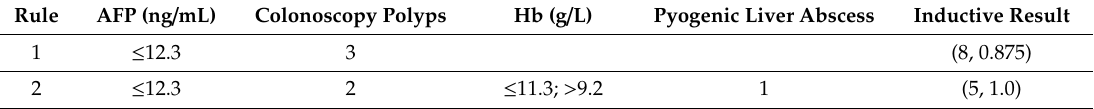
Figure 2. Decision tree model 1 (with pyogenic liver abscess variable). Table 7. Model 1 (with bacterial liver abscess) classification results—colorectal cancer.